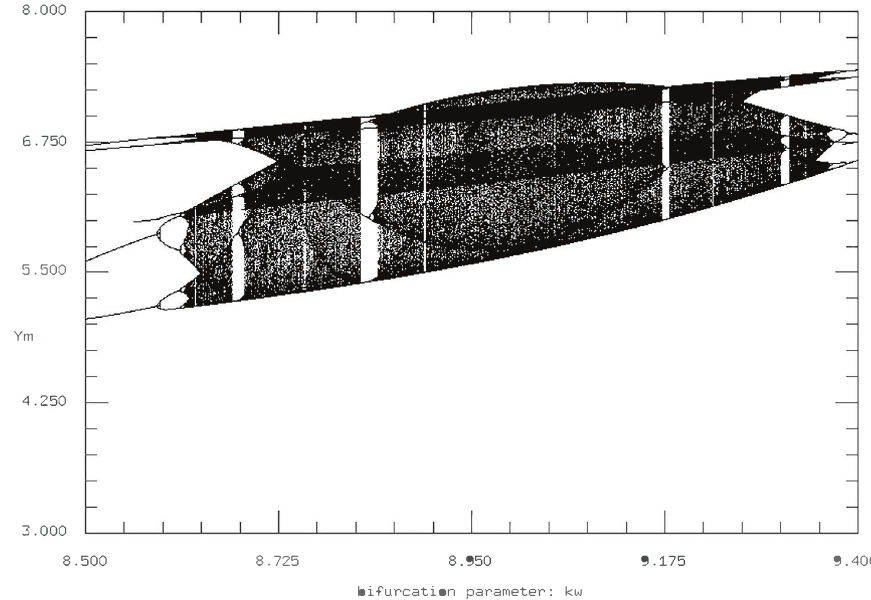
Figure 11. Bifurcation diagram of maxima of Y m for k w and k f = 0 and other parameters from Table